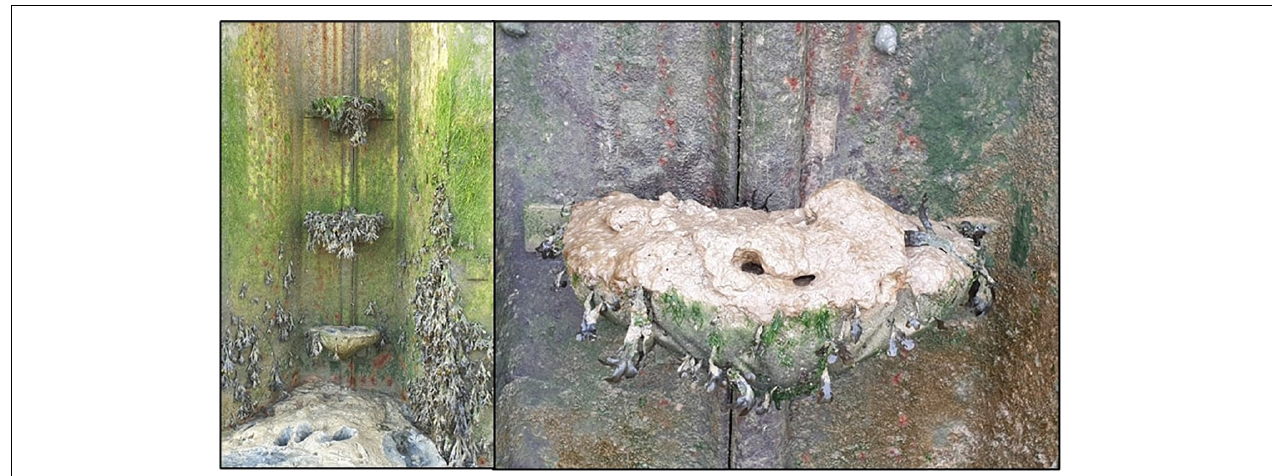
FIGURE 2 | (Left) One of the three columns of artificial rockpools. The rockpools were fixed to the in-pan of the steel sheet piling. The top rockpool was fixed at approximately Mean High Water Neap Tide Level. The foot of the sheet piling was approximately Mean Tide Level. (Right) An artificial rockpool on the steel sheet piling filled with mud, photographed 2.5 years after